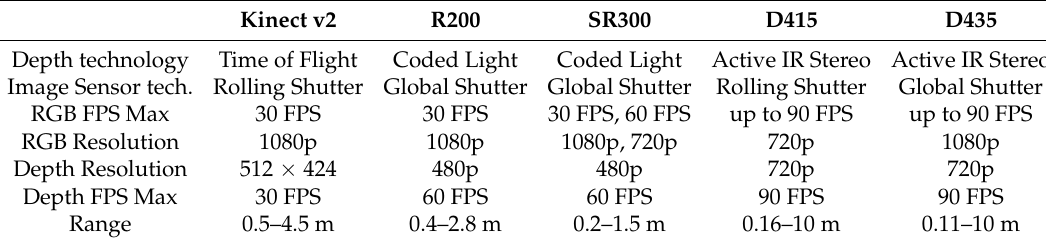
Table 3. Comparison of depth